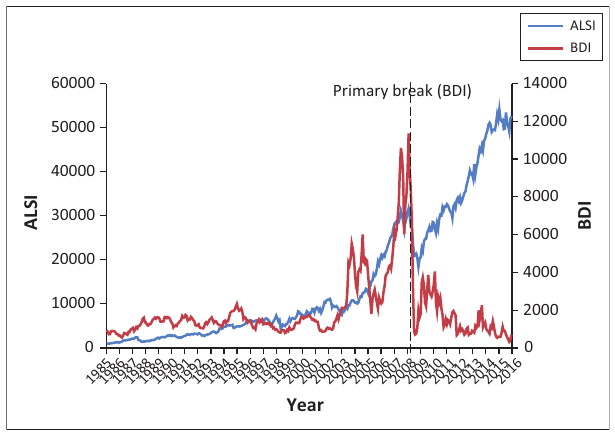
FIGURE 4: Baltic Dry Index and All Share Index trends (including identified break).